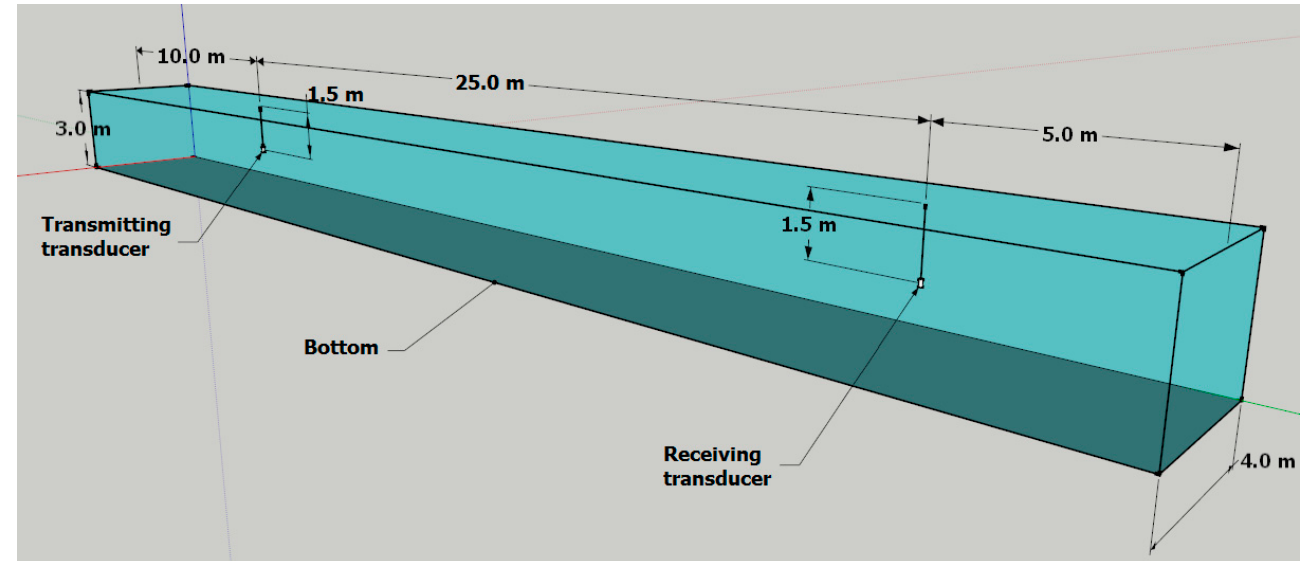
Figure 8. Dimensions of the model pool and the location of transmitting and receiving transducers.